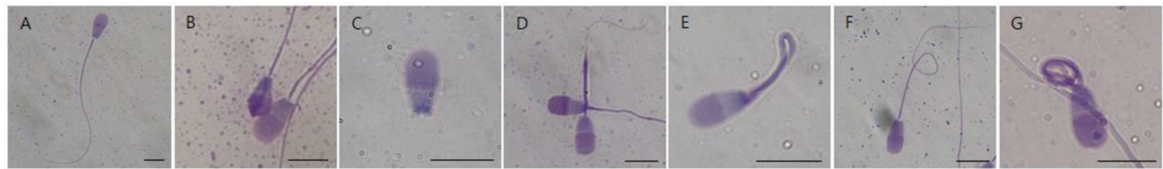
Figure 2. Morphology of bovine sperm determined by Diff-Quik staining. ( A ): Normal; ( B ): abnormal head; ( C ): detached head; ( D ): abnormal midpiece; ( E ): bent midpiece; ( F ): bent tail; and ( G ): coiled tail. Scale bars, 5 µ